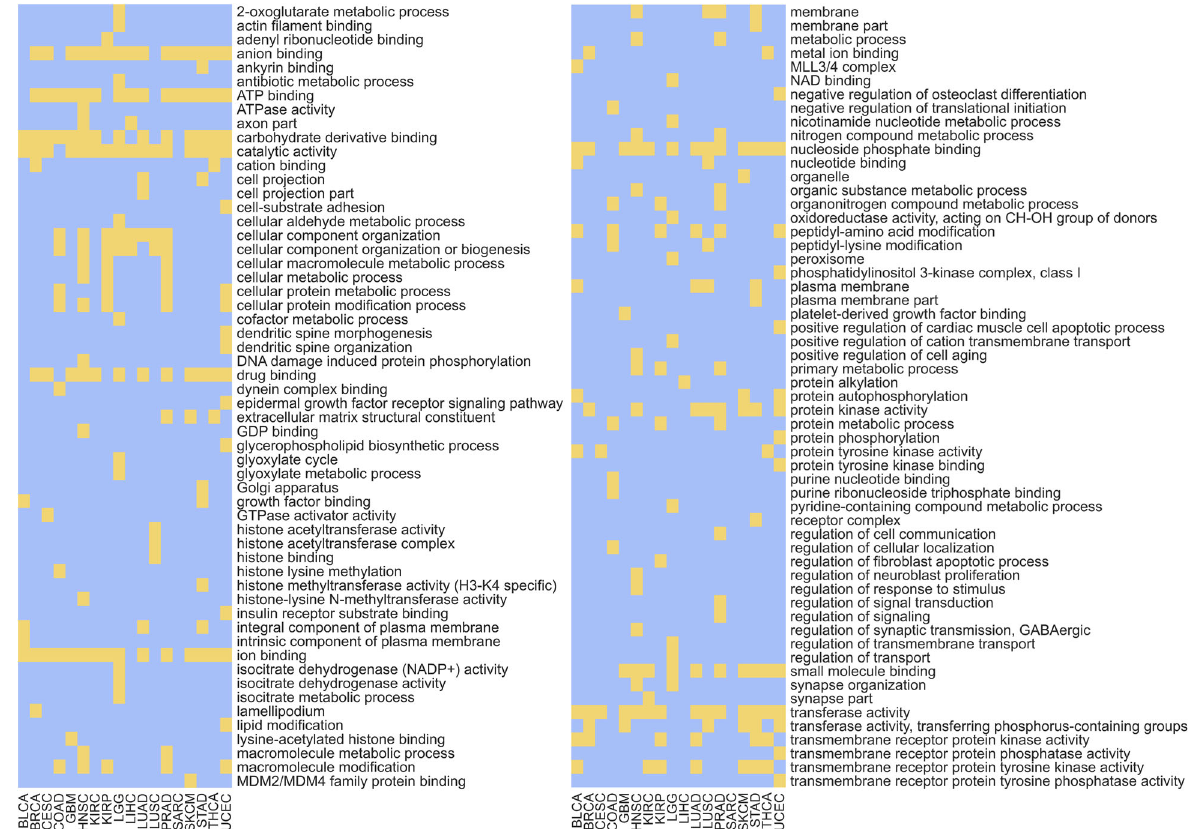
Fig. 7 GO terms enrichment for the 19 cancer types. Received by using the gene rankings of all features models. The fi gure is constructed of two panels for readability purposes and is equivalent to a single long panel with 113 GO terms. Each row in a panel refers to a GO term and every column in a panel refers to a cancer type. Yellow positions indicate non-redundant enriched GO terms with a p-value smaller than 0.001 and a q -value (FDR correction) smaller than 0.05. Blue positions indicate GO terms that are not enriched under these